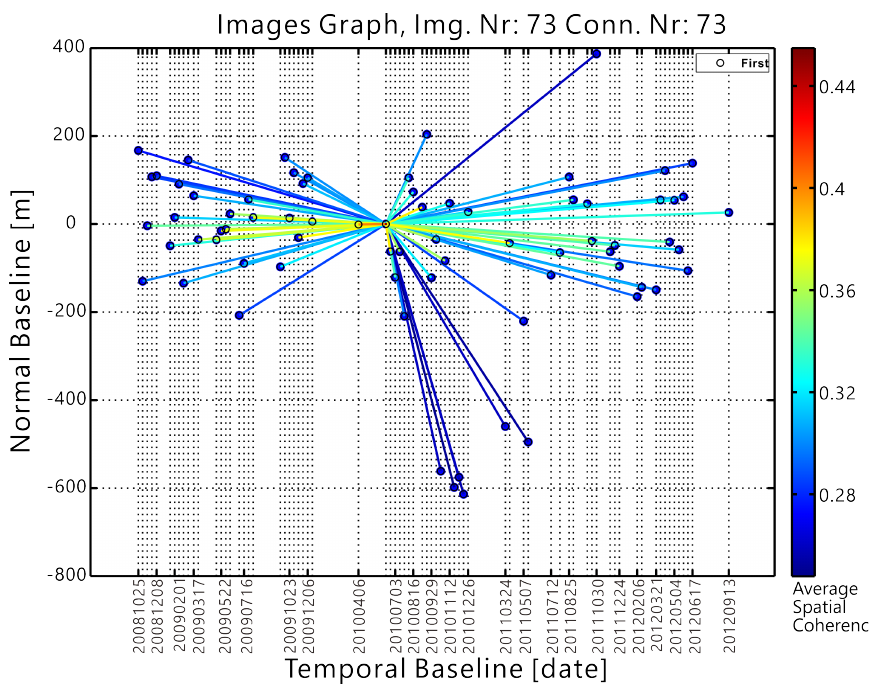
Figure 2. This is the figure showing TSX and TDX images used in our analysis, where the x-axis indicates the temporal baseline and the y-axis indicates the perpendicular